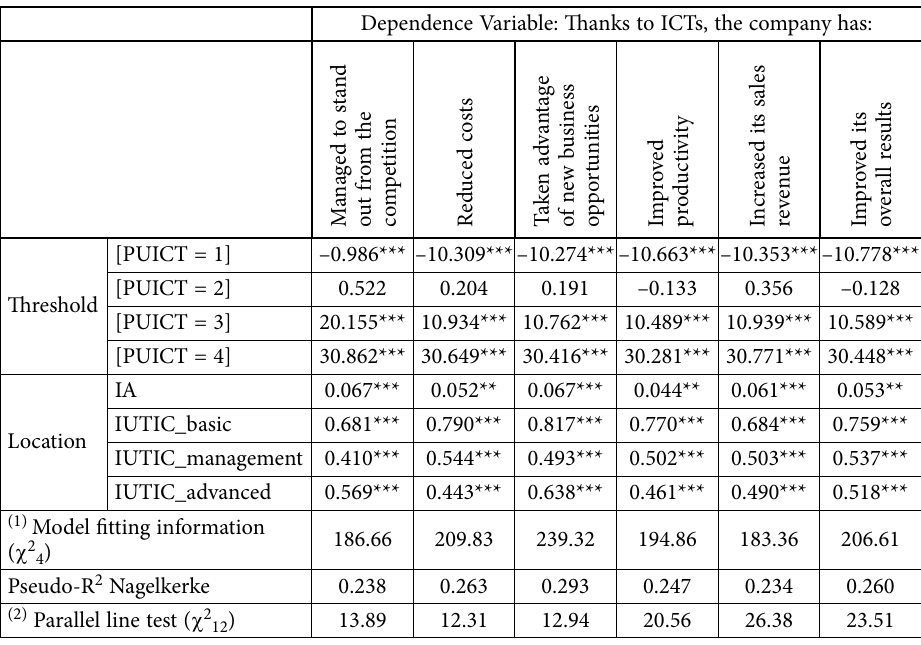
Table 4. Ordered logistic regressions (source: own compilation) HYPOTHESIS 1: PUICT = f(IUTIC); HYPOTHESIS 2: PUICT =